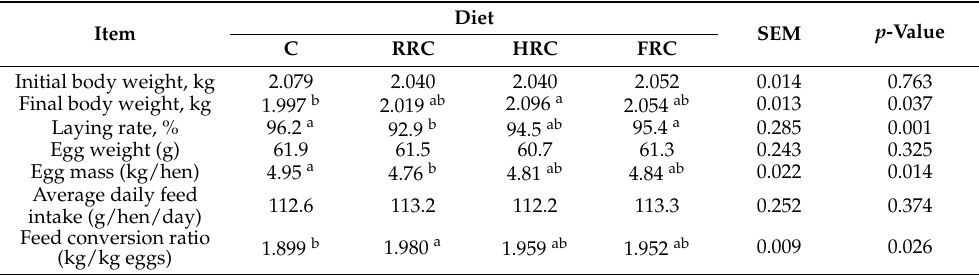
Table 3. Performance of laying hens fed raw (RRC), hydrobarothermally-treated (HRC) and fer- mented (FRC) rapeseed